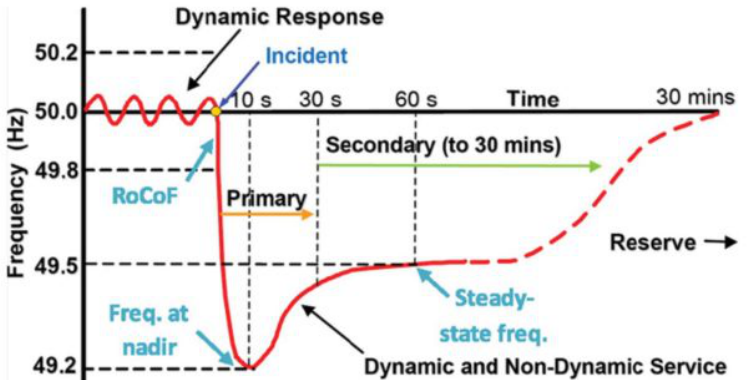
Figure 7. An example of the different responses to a grid frequency event